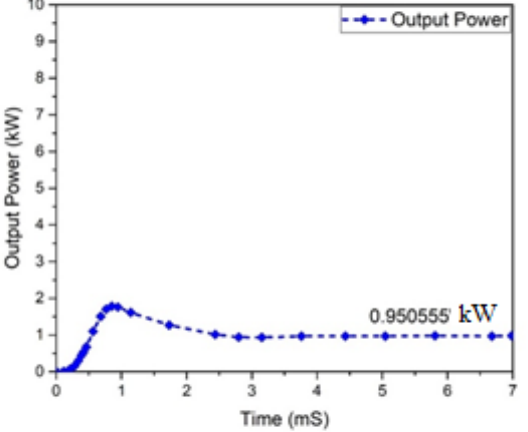
Figure 11. Output power of Flyback boost converter.